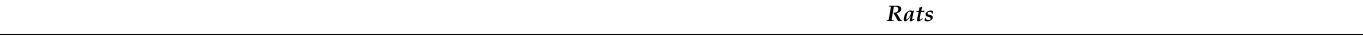
Number of Experimental Models and Allocation